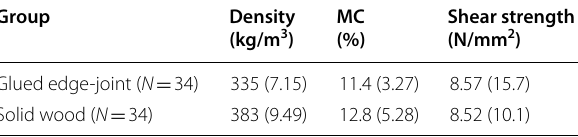
The left and right values in the cell are the mean value and CV (in percentage) N , number of specimens; MC, moisture content